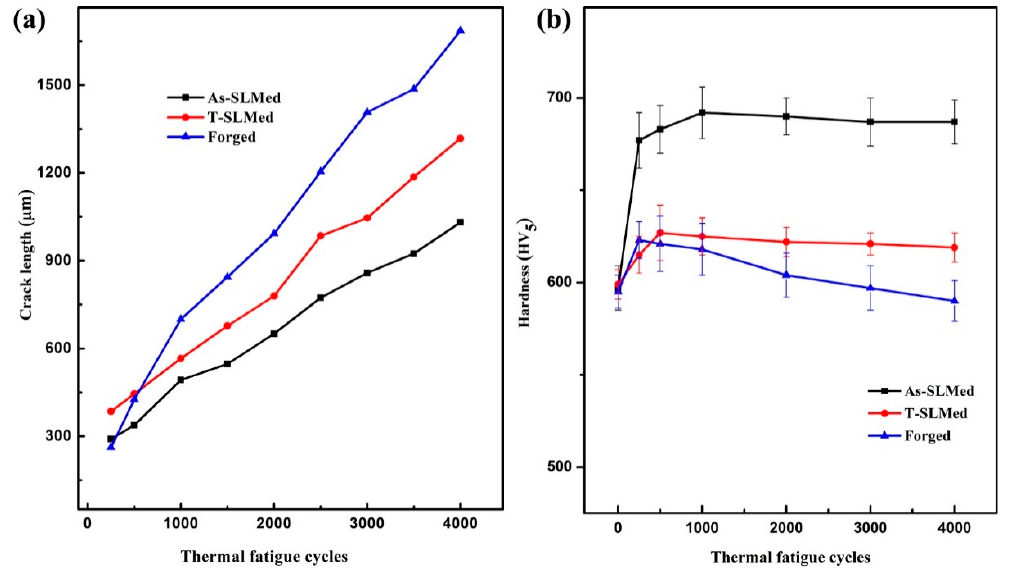
Figure 8. ( a ) Crack length and ( b ) microhardness of the As ‐ SLMed, T ‐ SLMed, and Forged H13 after different numbers of TF testing cycles (650 °C/30 °C).